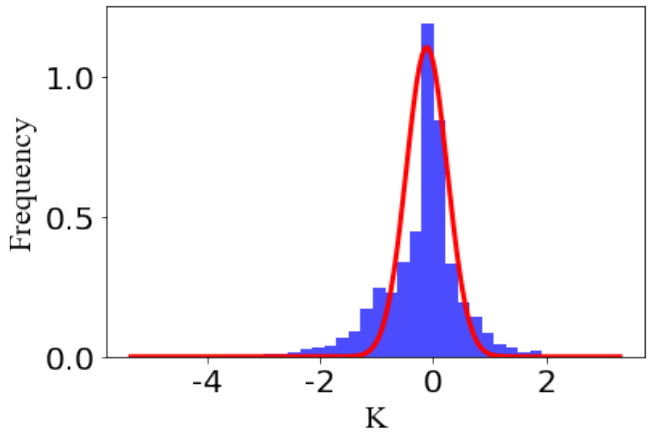
Figure 6. Slope distribution of horizontal